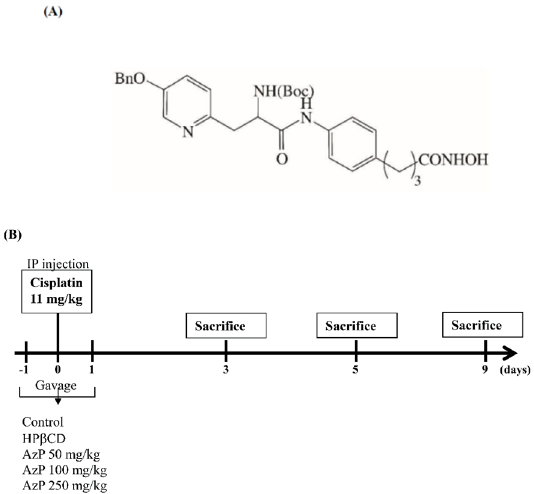
Figure 1. ( A ) Structure of Azatyrosine-phenylbutyric hydroxamides (PBHA), AzP; ( B ) A schematic of AzP on Cisplatin-induced mucositis. C57BL/6 mice were treated with 11 mg/kg/day cisplatin on day 0. Gavages of 50, 100, and 250 mg/kg AzP were given on days − 1, 0, and 1. From a total of 9 mice, 3 were sacrificed on days 3 and 5, and their intestine collected for further immunohistological observations. Weights were recorded daily until day 9.